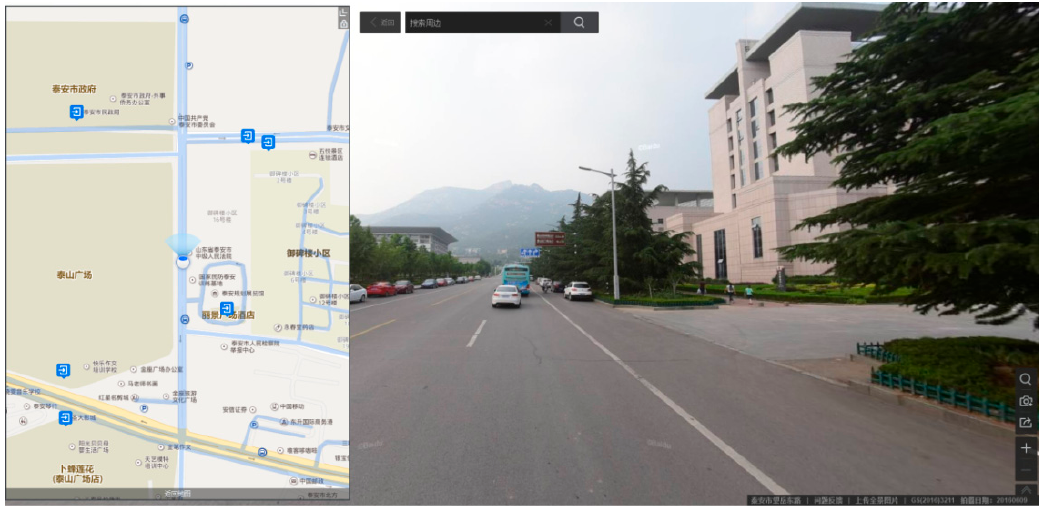
Figure 3. A Baidu street view (BSV) in the study area.